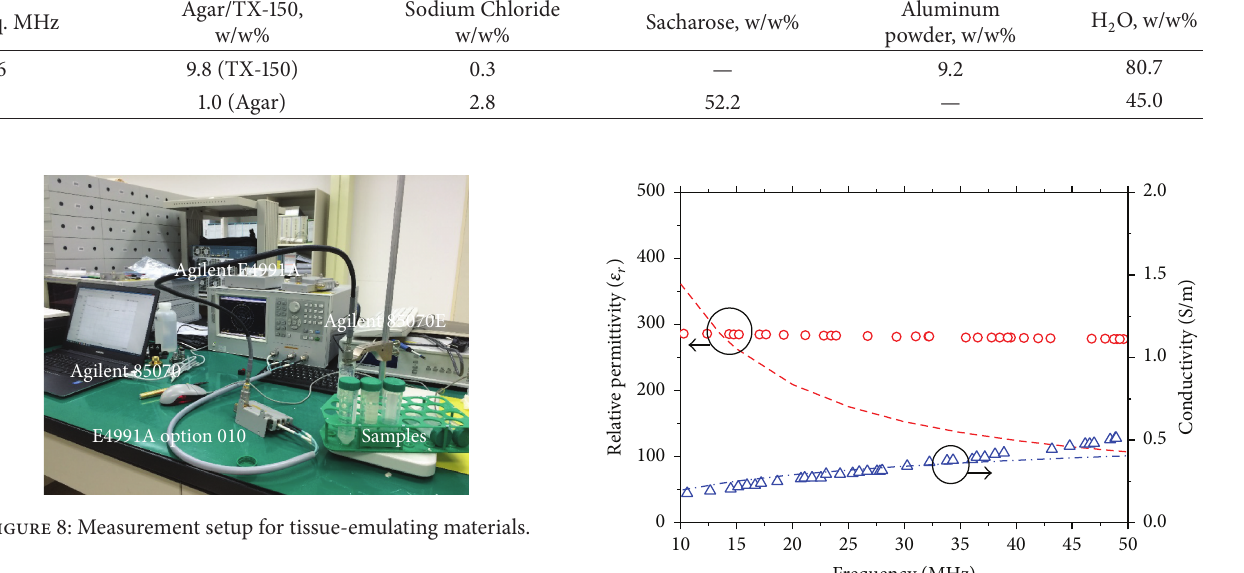
Table 1: Recipe of human dry skin tissue-emulating material for 13.56 MHz and 400 MHz. Freq. MHz